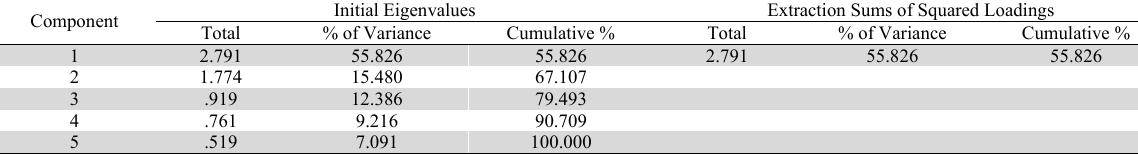
The variance extracted when factor analysis of dependent variables